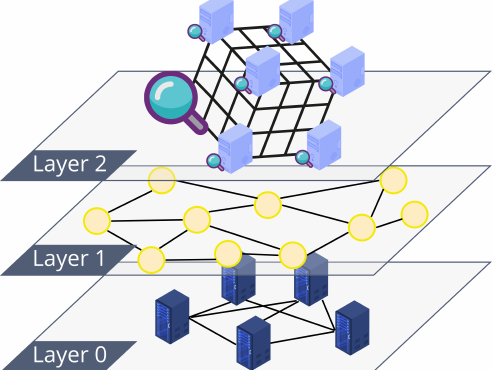
Figure 2. Layers in the context of DLTs. Layer zero consists of the DLT network, while Layer-1 is the set of software frameworks run by the network nodes (e.g., the ledger). Layer-2 solutions are the ones that leverage Layer-1 for other services, i.e., the hypercube DHT in our